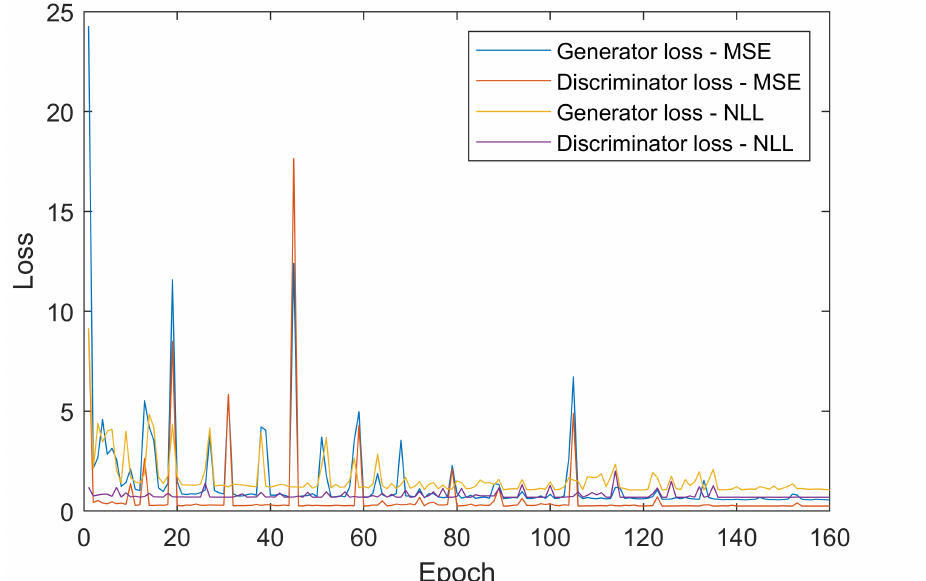
Figure 4. The loss curves of MSE and NLL for both discriminator and generator during training when applying the HED detection